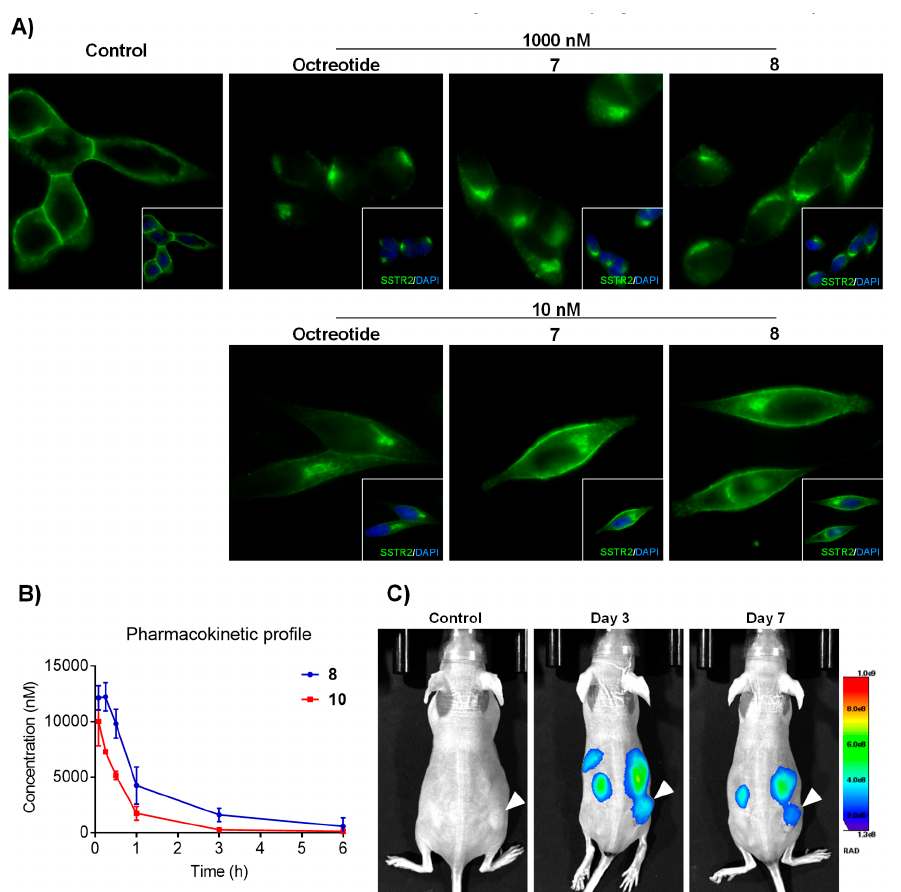
Figure 2. ( A ) Concentration-dependent internalization of SSTR2 in AtT20 cells. Cells were treated for 30 min at 37 °C with 10 or 1000 nM of octreotide and corresponding oc- treotide-cryptophycin conjugates 7 and 8 . ( B ) Pharmacokinetic profile of conjugates 8 and conjugates 7 and 8 . ( B ) Pharmacokinetic profile of conjugates 8 and 10 in heterozygous NCR mice. 10 in heterozygous NCR mice. ( C ) In vivo tumor targeting of the conjugate 10 using the ( C ) In vivo tumor targeting of the conjugate 10 using the AtT20 xenograft-bearing mice. Animals AtT20 xenograft-bearing mice. Animals were intravenously injected with 1 mg/kg of con- jugate 10 and whole-body images were taken at the indicated timepoints. were intravenously injected with 1 mg / kg of conjugate 10 and whole-body images were taken at the indicated